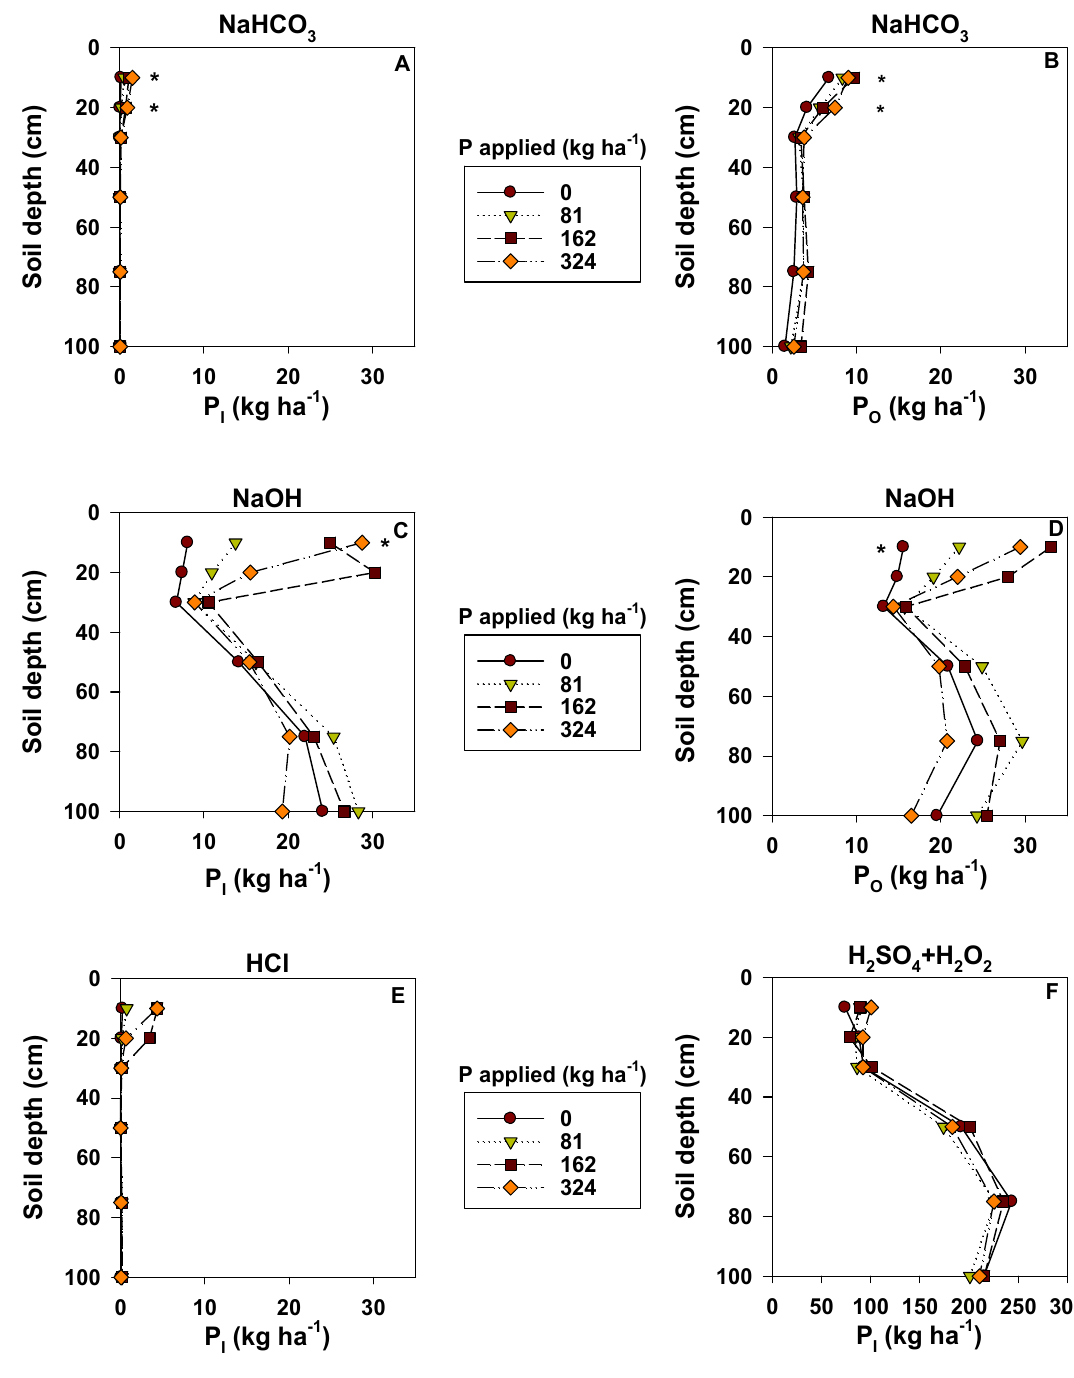
Figure 3. Phosphorus fractions in a loamy Ultisol in the western Gulf Coastal Plain of the United States 27 years after high rates of triple superphosphate fertilization. * Significant difference at p < 0.05 at that soil depth. P organic